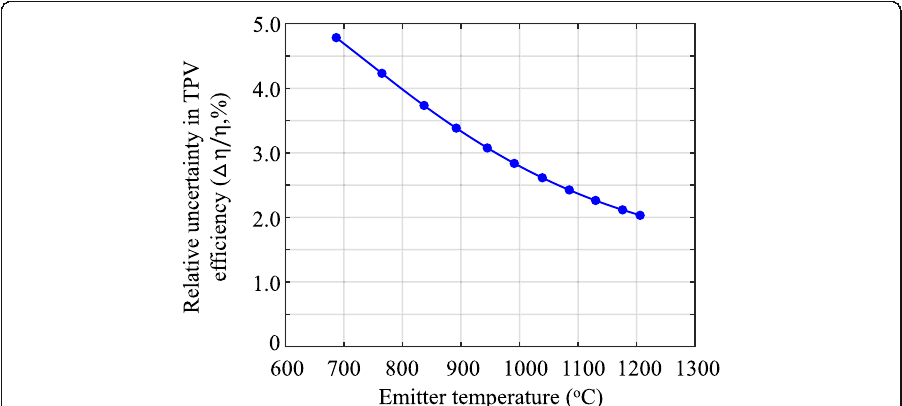
Fig. 6 Accurate calibration of record thermophotovoltaic efficiency. The uncertainty in efficiency is mainly determined by the relative uncertainty of the sub-bandgap reflectivity. As the emitter temperature increases, more photons are emitted above the band-edge than below. This results in a higher signal-to- noise ratio with increasing